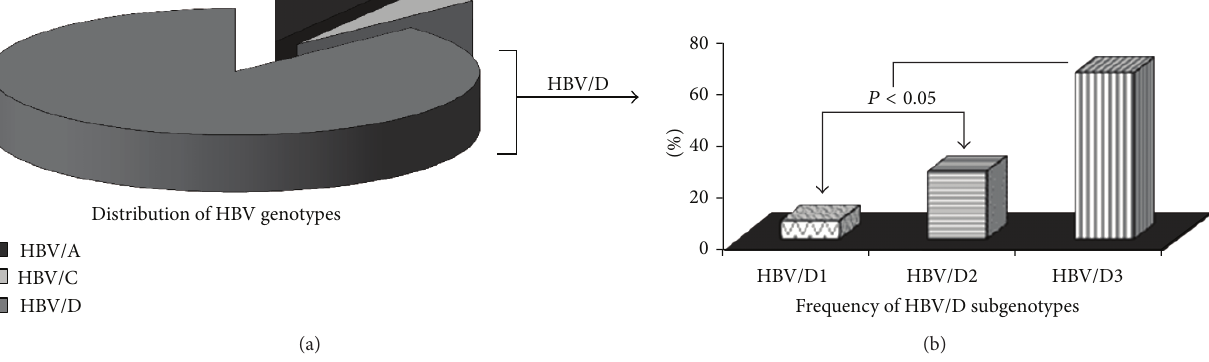
Figure 2: Distribution of HBV genotypes/subgenotypes among the blood donors is represented by pie diagram. The frequencies of different subgenotypesofHBV/Darealsodepicted.The 𝑃 value( < 0.05)indicatesthattheprevalenceofHBV/D3wassignificantlyhigherincomparison to HBV/D1 and HBV/D2. Table 2: Frequency of basal core promoter and precore mutations among the occult HBV isolates. HBV Mutations (%)